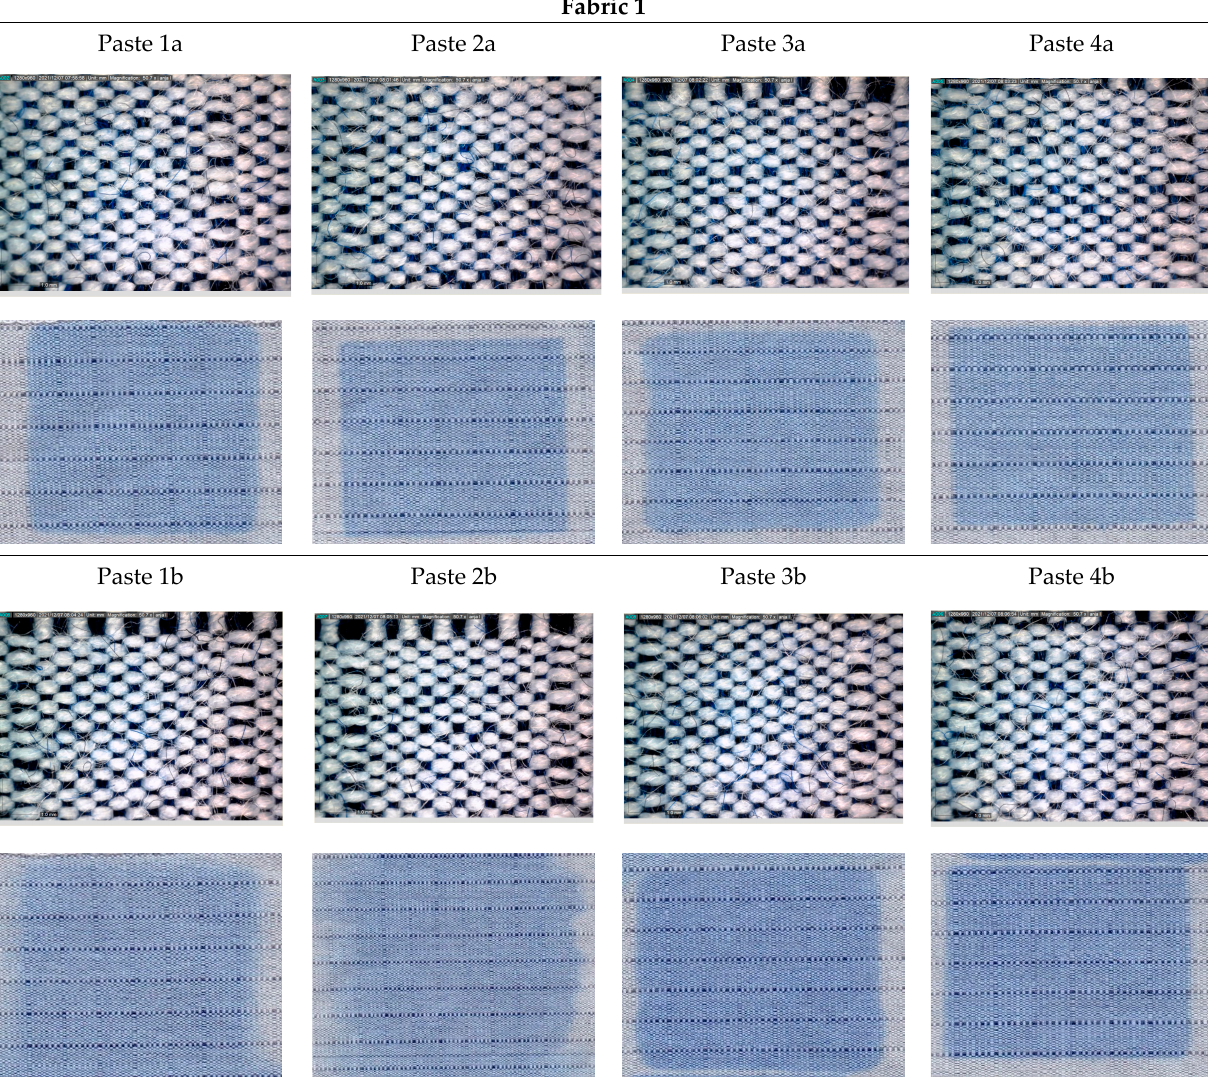
Figure 1. DinoLite microscopic and scanned images of printed Fabric 1. The result indicates that a thickener with a higher dry matter content is suitable for this type of fabric with a hydrophobic fiber content (aramids and PA), as in the case of the indicated pastes, regardless of the type of thickener. The microscopic images clearly show the component of aramid yarn that remained uncolored, and the proportion of the same is visible due to the characteristic of the weaving. Since the appearance of the color de- pends on the interaction of simultaneous remission from the dyed and undyed compo- nents of the fabric, an influence of the uncolored component on obtained color appearance can be expected.